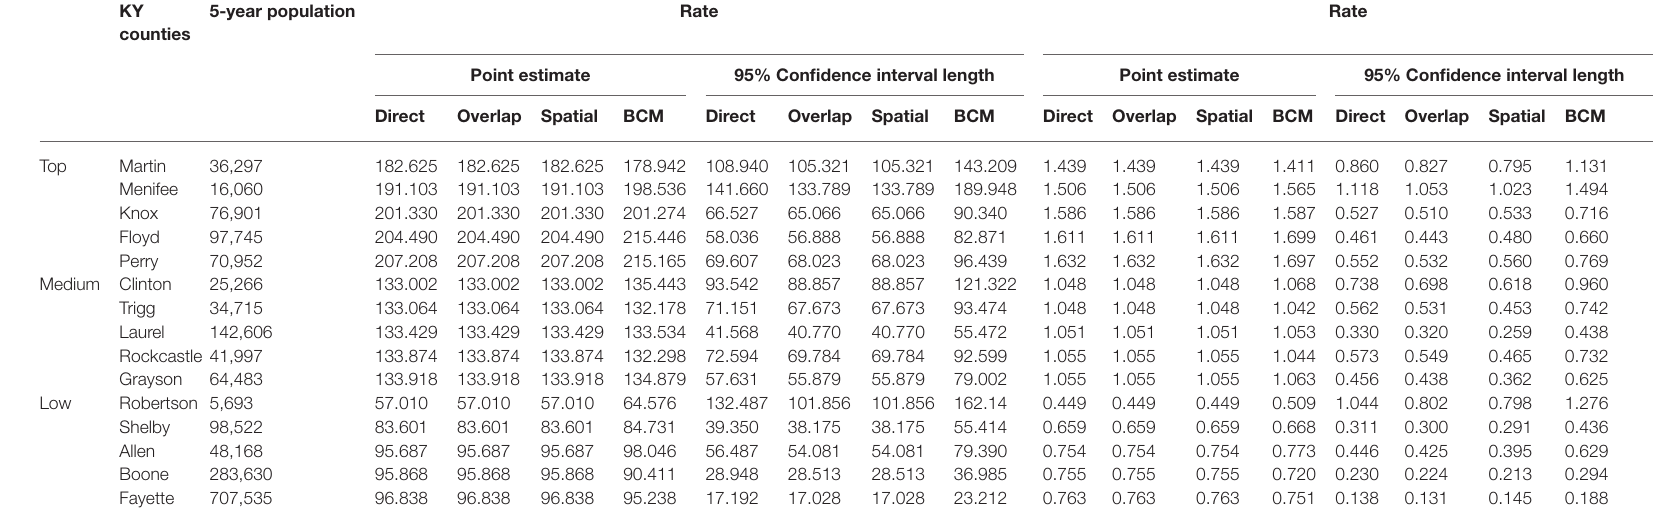
TABLE 4 | Age-adjusted rate and rate ratio in top, middle, and bottom five counties based on 2006–2010 lung cancer incidence rate in Kentucky.